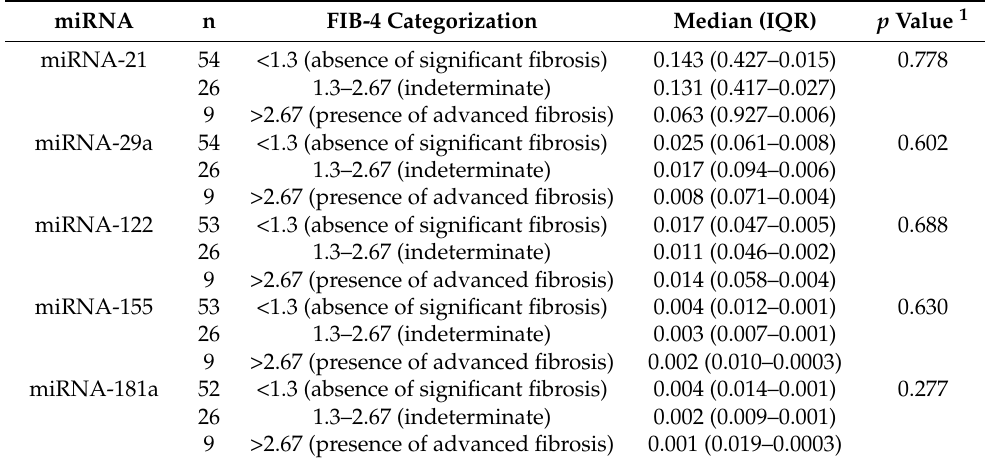
Table 3. Comparison between microRNAs and Fibrosis index-4 (FIB-4) categorization.